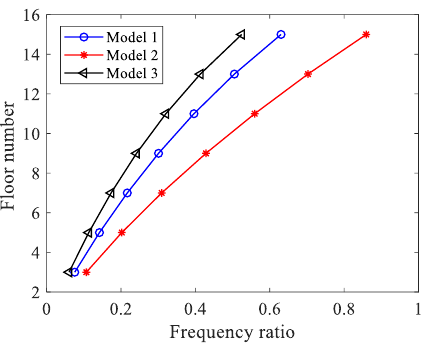
Figure 10. The energy reduction coefficient versus the position of the damping layer. Table 1. The 1st frequencies of substructures 1 and 2 and the ratios between